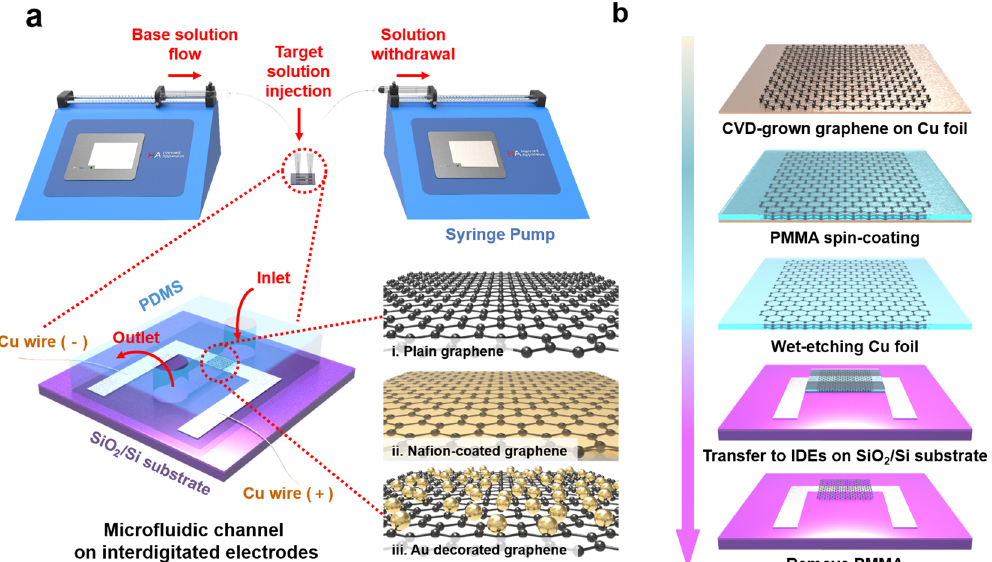
Fig. 1 Schematic of the overall experiment and sample fabrication. a Schematic diagram of the device; syringe pump for injection and withdrawal of solutions, micro fl uidic channel-attached interdigitated electrodes, pristine graphene, Na fi on-coated graphene, and Au- decorated graphene. b Sample fabrication illustration of CVD graphene